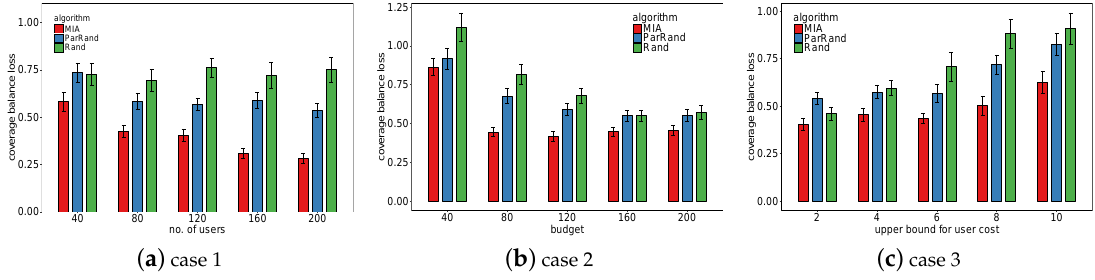
Figure 9. Comparison of the three algorithms in coverage balance